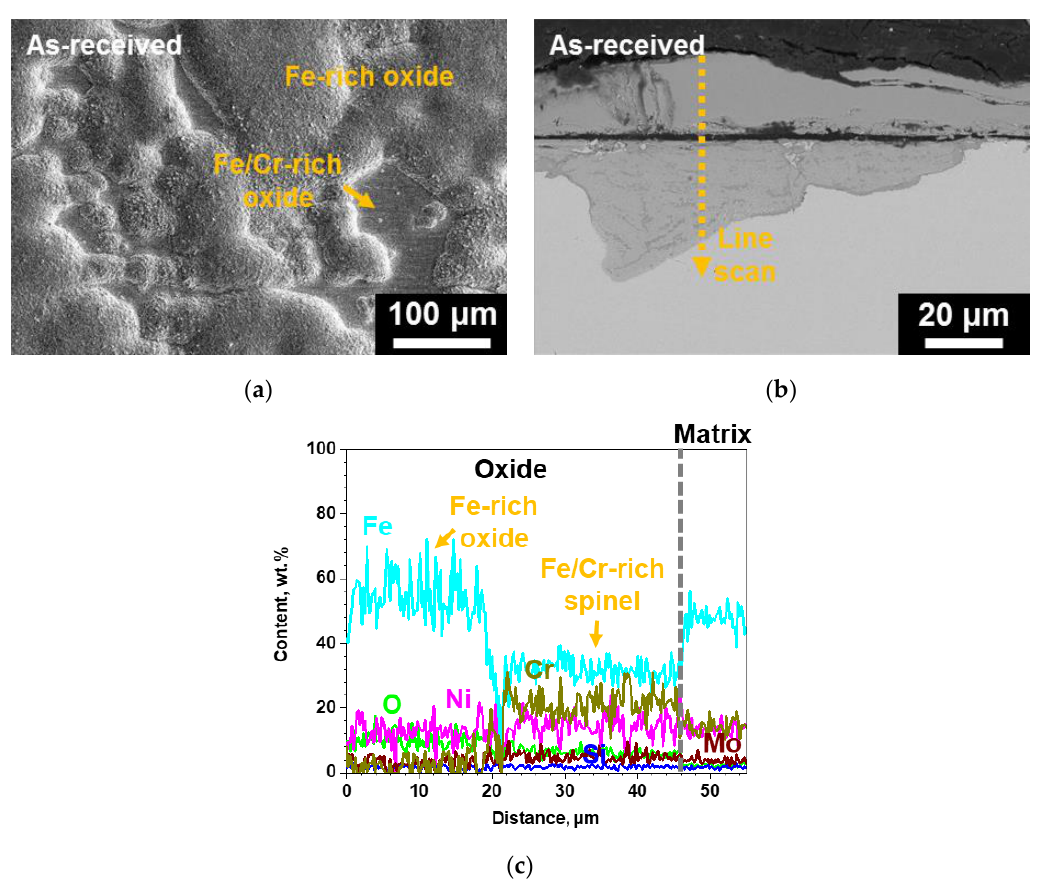
Figure 8. ( a ) Surface SEM, ( b ) cross-sectional BSE micrograph of the as-received SS 316LN after exposure to steam at 650 °C (0.1 MPa) for 500 h, and ( c ) result of EDS line scan along the dotted line in (b).